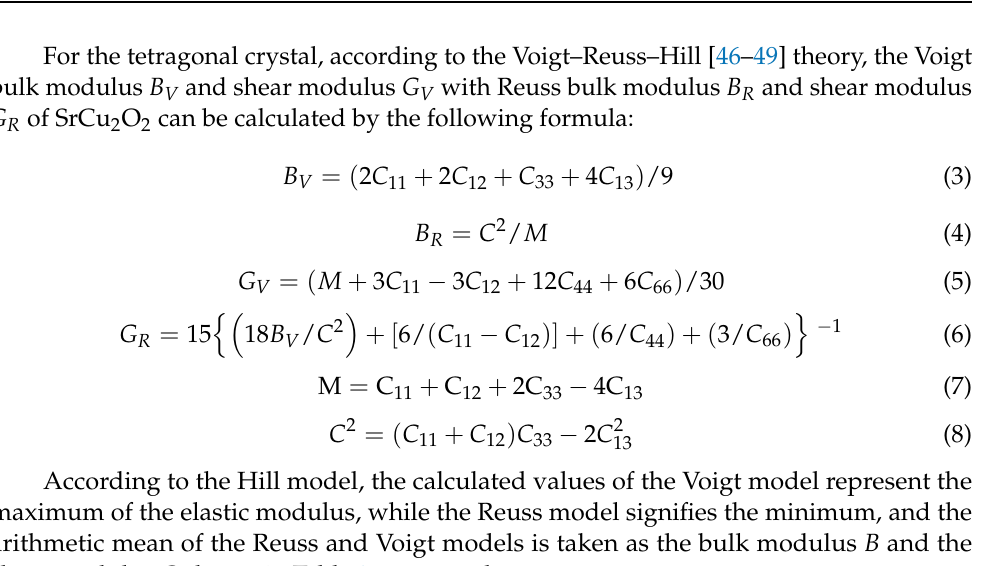
Table 4. Calculated elastic constants C ij , bulk modulus B , shear modulus G , Young’s modulus E , Poisson’s ratio ν , Pugh’s empirical parameter B / G, and Cauchy pressure C (cid:48) . Elastic Constants (GPa) Elastic Moduli (GPa) C 11 C 12 C 13 C 33 C 44 C 66 G ν B / G C ’ 94.9